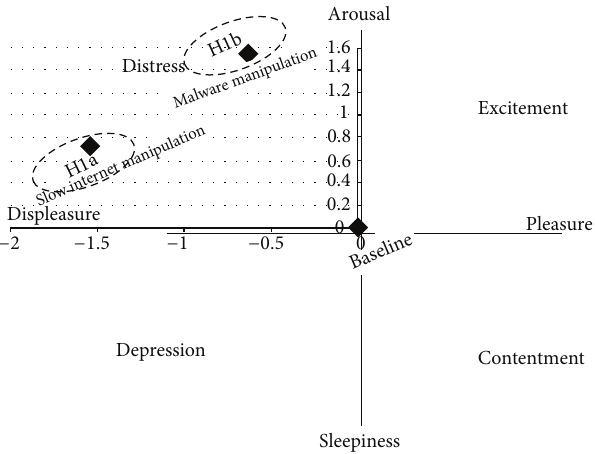
Figure 6: Valence and arousal reports for each session are overlaid on Russell’s circumplex model. We subtracted the baseline (day two) arousal and valence measures from days two, three, and four to shift the data so that baseline was at point (0,0) in Russell’s